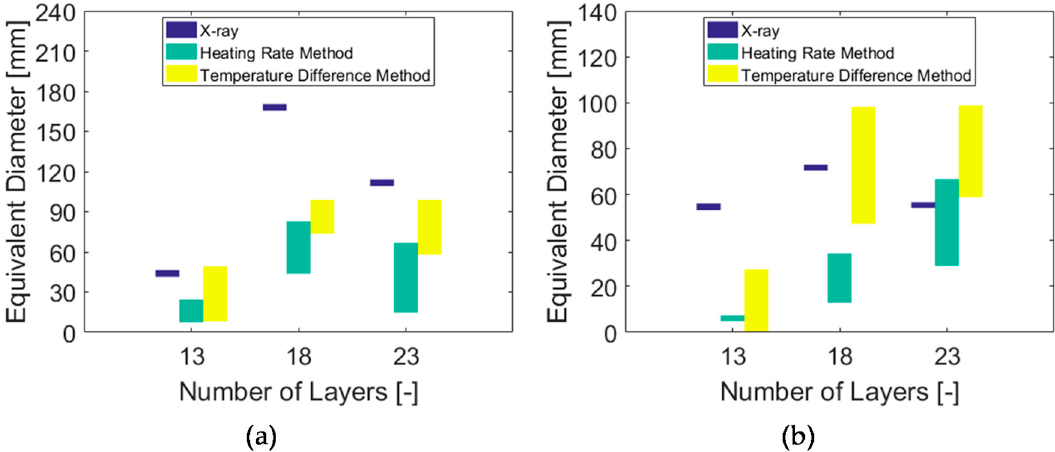
Figure 4 Comparison of the quantitative values of equivalent damaged diameter for the three techniques presented. ( a ) specimens impacted with the 9 mm projectile and ( b ) with the .357